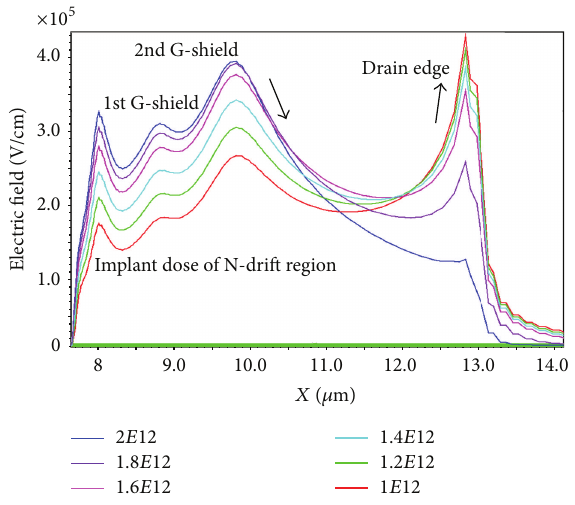
Figure 3: Crucial electric field distribution along the surface of N-drift region when breakdown occurs for different given implant energies of the N-drift